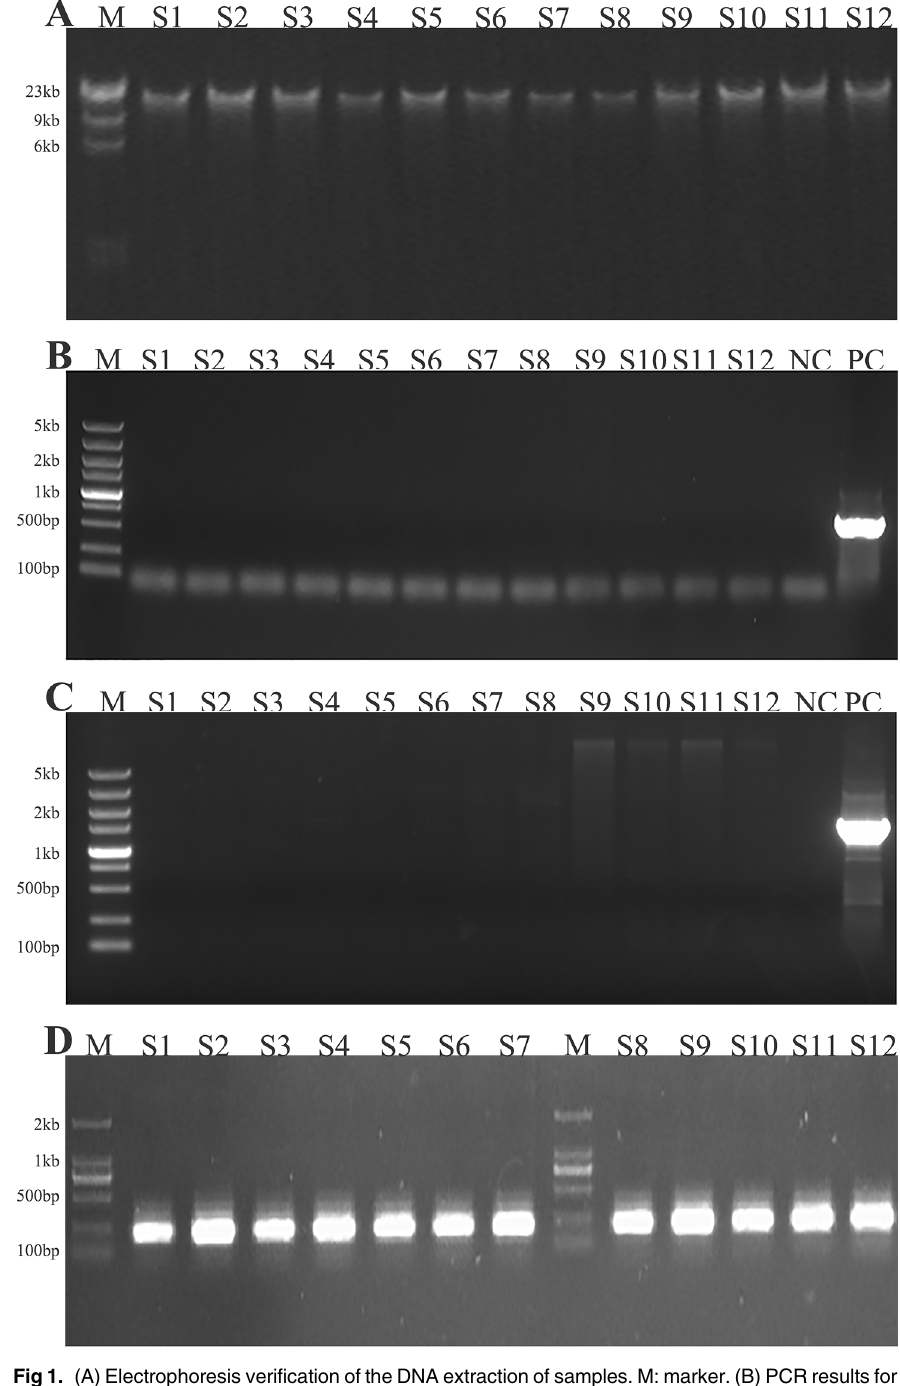
Fig 1. (A) Electrophoresis verification of the DNA extraction of samples. M: marker. (B) PCR results for the growth hormone gene detection experiment. NC: negative control with ddH 2 O. PC: positive control with pcGH vector over-expression. (C) PCR result of the neoR gene detection. NC: negative control with ddH 2 O. PC: positive control with over-expression of the pcGH vector. (D) PCR amplification of the 16 s rDNA of bacteria from samples.